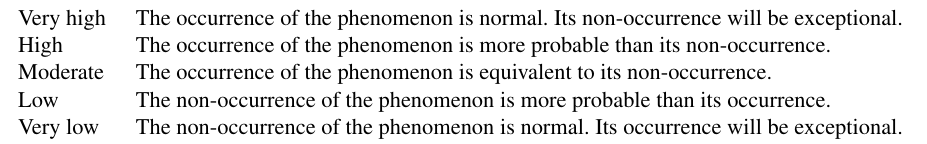
Table 1. Qualitative scale of the level of occurrence probability, after the guide of the Laboratoire des Ponts et Chaussées (2004). Very high The occurrence of the phenomenon is normal. Its non-occurrence will be exceptional.